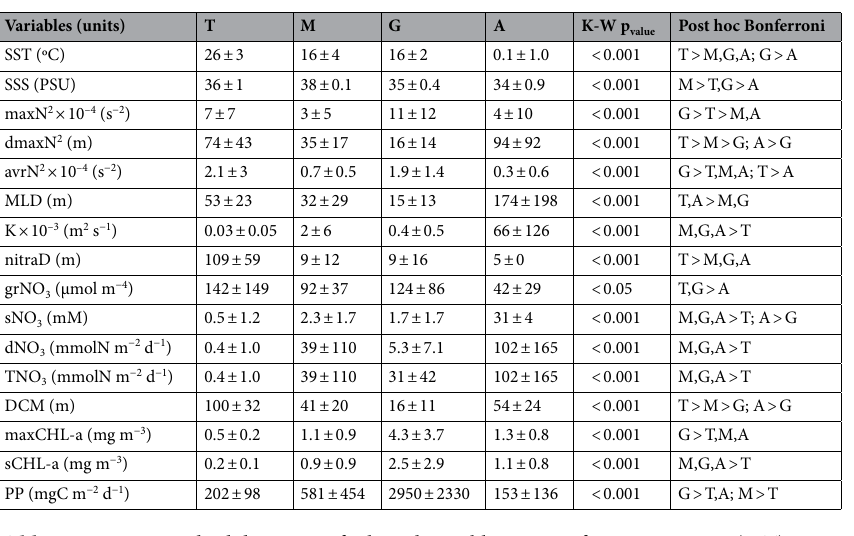
Table 2. Mean ± standard deviation of selected variables. Sea surface temperature (SST), sea surface salinity (SSS), vertical stratification in the pycnocline (maxN 2 ), depth of the pycnocline (dmaxN 2 ), average stratification in the nitracline (avrN 2 ), depth of the mixed layer (MLD), vertical turbulent diffusivity (K), depth of the nitracline (nitraD), nitrate gradient across the nitracline (grNO 3 ), surface nitrate concentration (sNO 3 ), diffusive nitrate supply (dNO 3 ), total nitrate supply (including diffusive and advective fluxes, TNO 3 ), depth (DCM) and value (maxCHL-a) of the maximum chlorophyll-a, surface chlorophyll-a (sCHL-a), and photic layer depth-integrated net primary production (PP), computed for the tropical and subtropical regions (T), the Mediterranean Sea (M), the Galician coastal upwelling (G), and the Antarctic Peninsula (A). A nonparametric one-way ANOVA (Kruskal–Wallis, KW) was performed to test the null hypothesis that independent groups come from the same distribution. The Bonferroni multiple comparison test was applied a posteriori to analyze the differences between every pair of